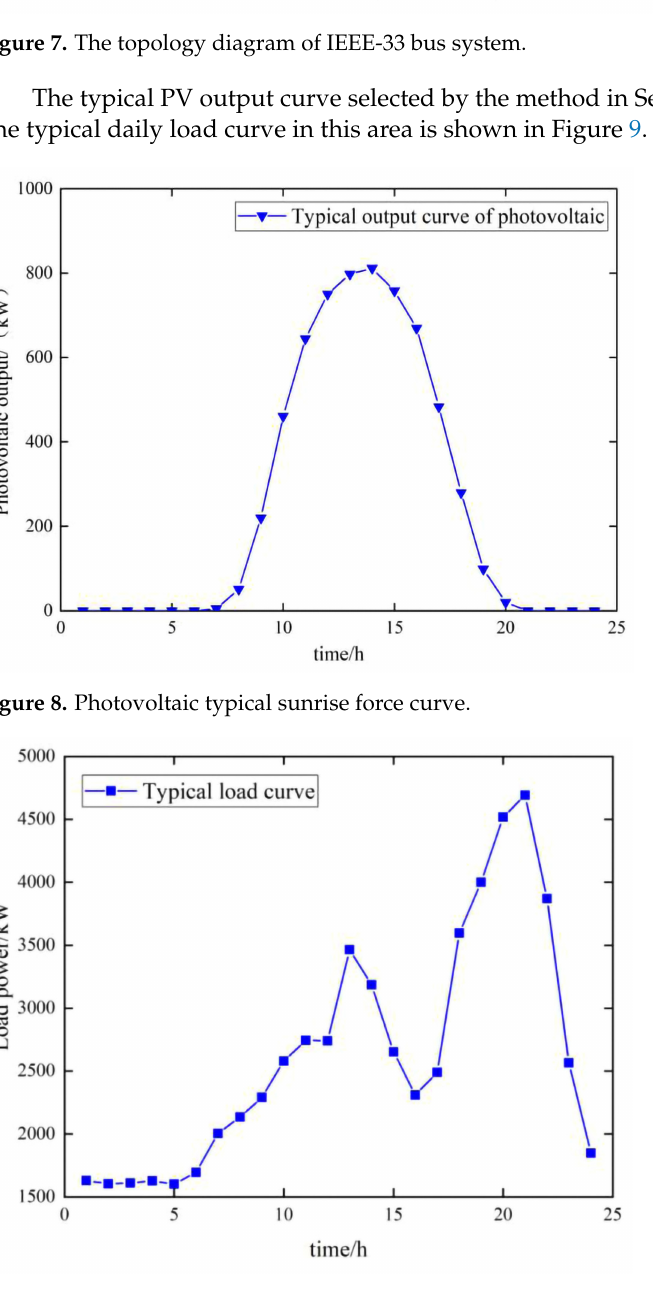
Figure 9. Typical daily characteristic curve of